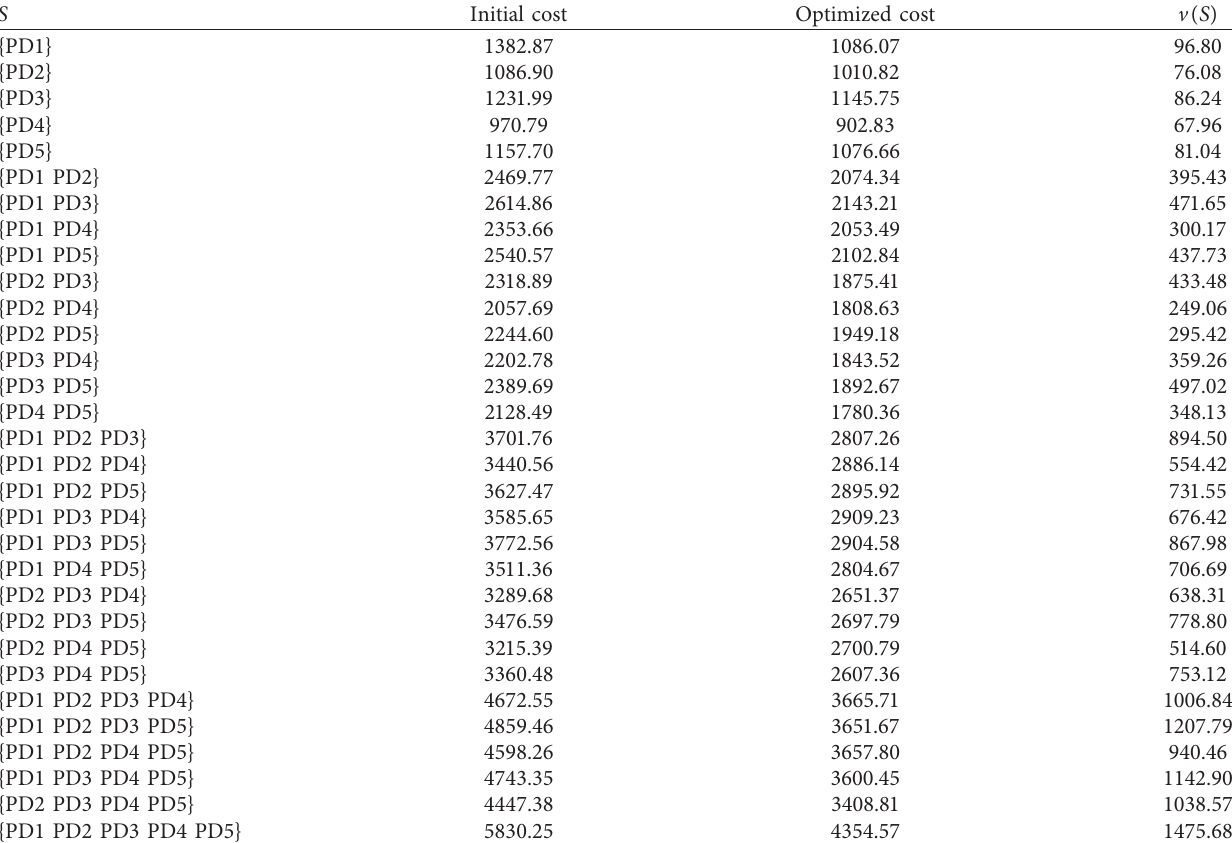
Table 6: Comparison between the initial and optimized network over one time period (unit: USD).